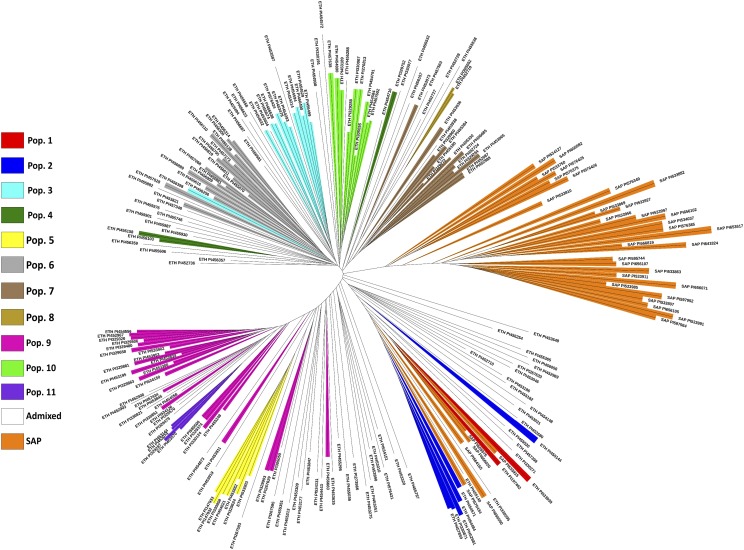
Unrooted neighbor-joining tree of 209 anthracnose resistant accessions present in the NPGS Ethiopian core set and in the Sorghum Association Panel (SAP). Colors represent the NPGS Ethiopian populations and the SAP.